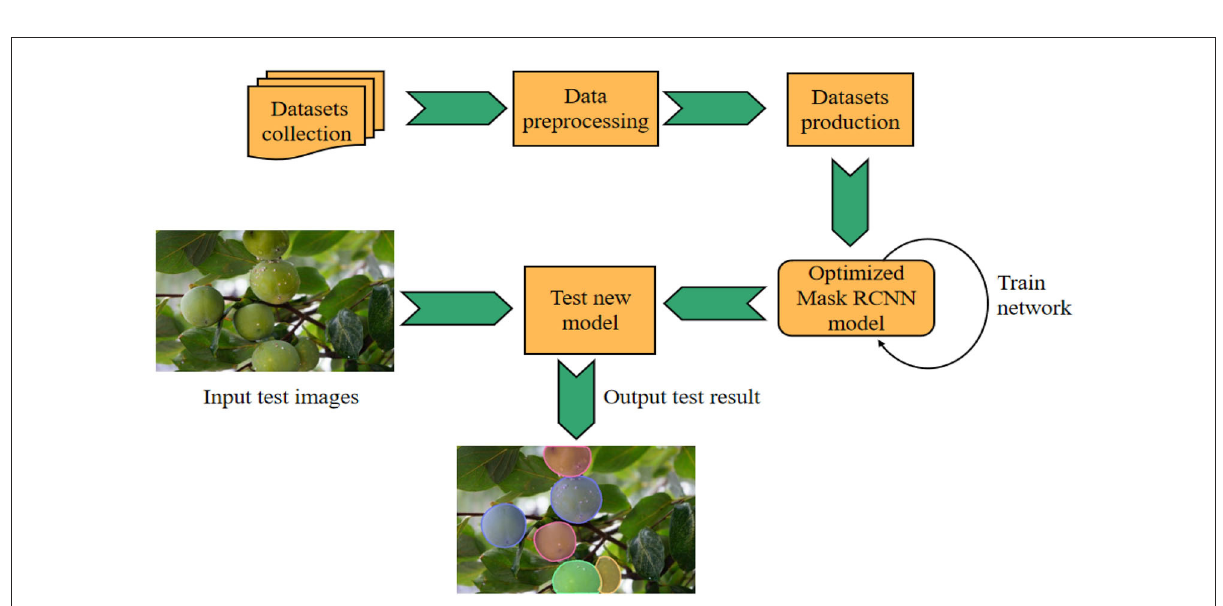
FIGURE7 Overall experimental flow chart based on optimized mask RCNN